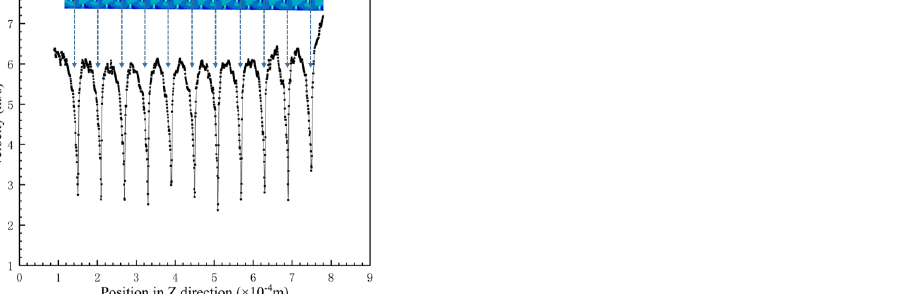
Figure 7. The velocity on the groove surface, and partially enlarges the contour of one crown.